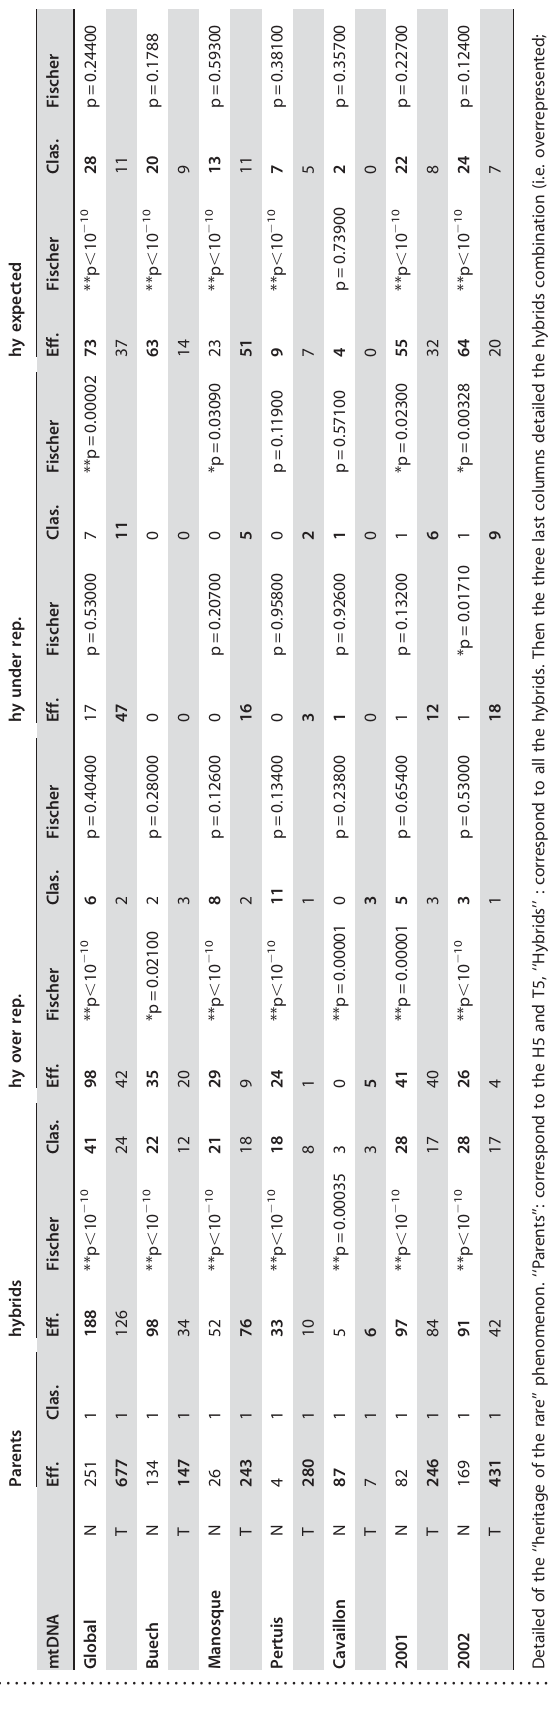
[16,17]), in all biological models. The Tpi 1b gene product is involved in glycolysis. We therefore searched the Danio rerio chromosome map for other genes encoding proteins involved in glycolysis. G3PDH, like Tpi 1b, was found to be present on chromosome 16 (region displayed: 58.99-59.01 cM). We identified no other candidate genes from the Danio rerio map in this chromosome region, but a more precise estimate of the